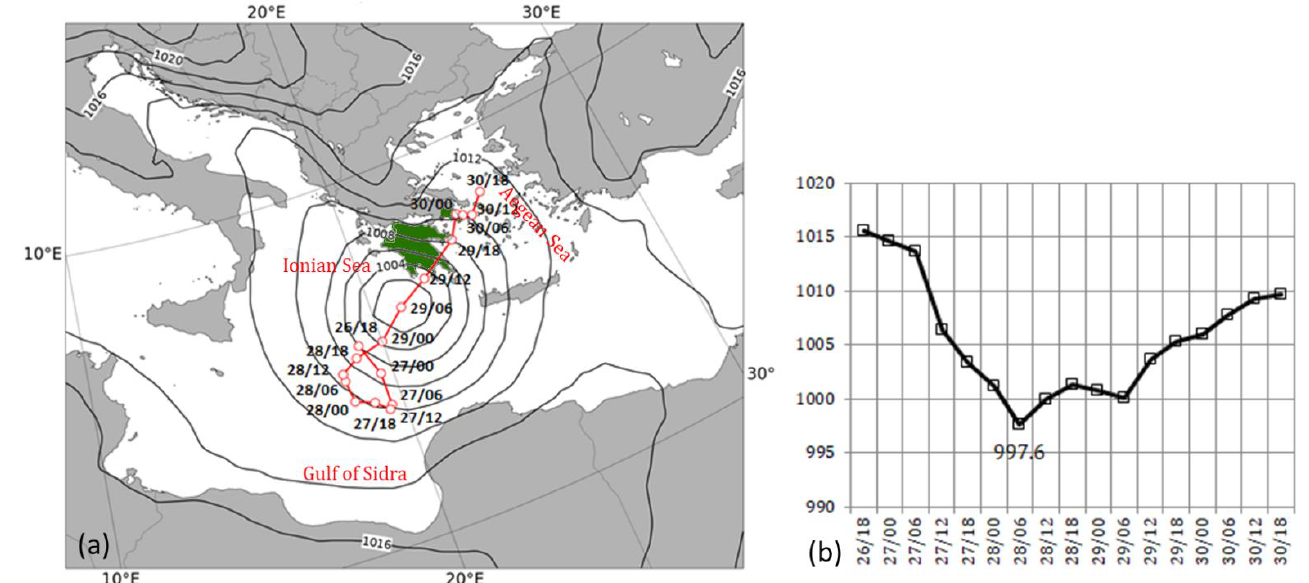
Figure 1. ( a ) System track as derived following the minimum pressure of the system from the ECMWF operational analyses. The lines are isobars at the time of medicane development at 29/06 UTC and ( b ) Temporal evolution of the mean sea level pressure at the centre of the system. The areas in green colour represent the Greek areas of the Peloponnese and Attica Peninsula that experienced the highest impact.